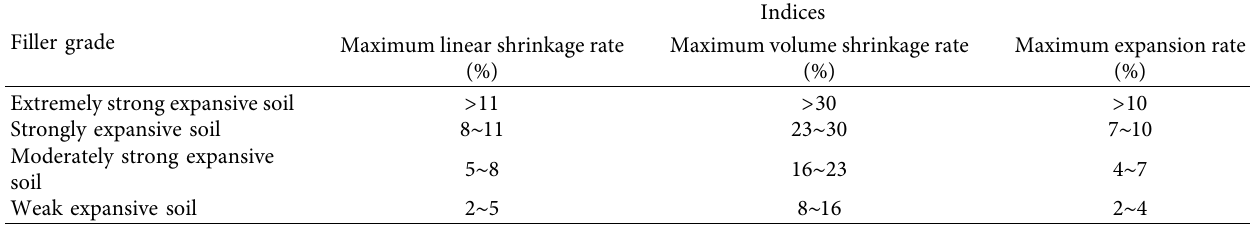
Table 4: Expansion and shrinkage grade standards of expansive